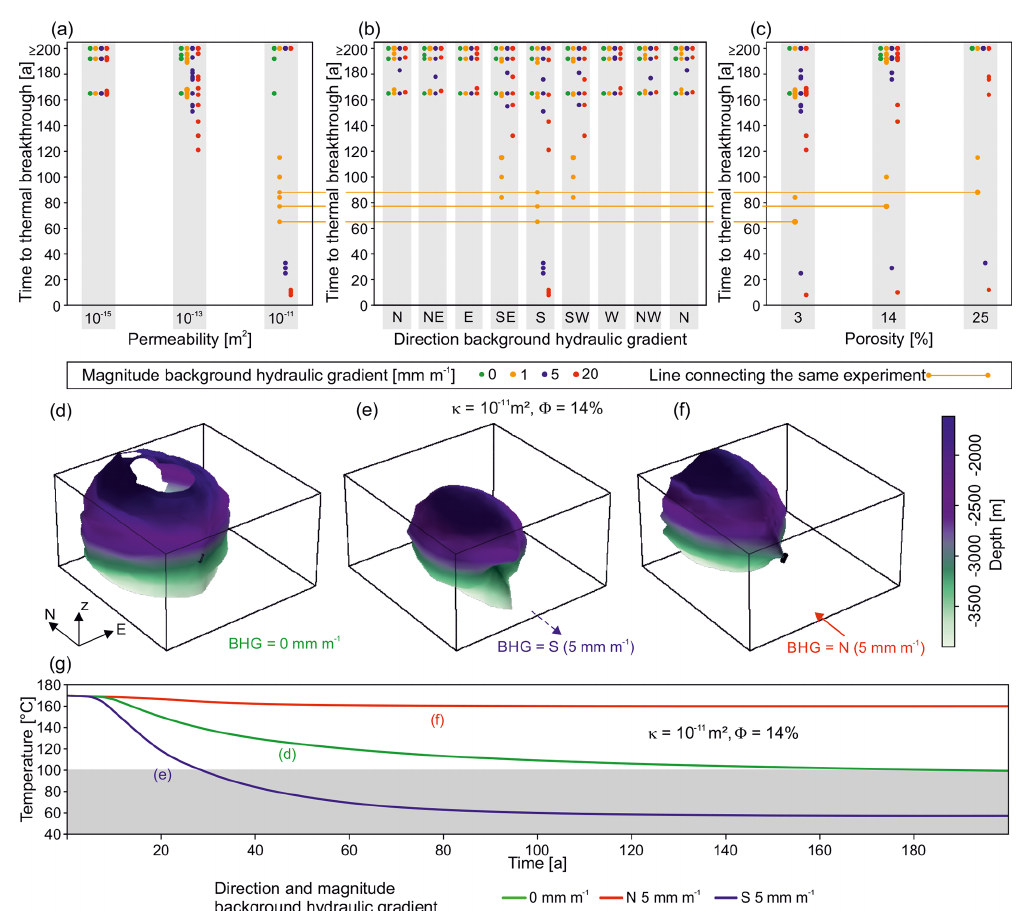
Figure 2. Parameter values against time to thermal breakthrough for model experiments with homogenous and isotropic structure (Scenario 1). Panels (a) , (b) , and (c) each contain the same results of 225 simulations but are arranged according to different x axes. The results show that with increasing permeability, the BHG becomes the prime factor that determines time to thermal breakthrough, while the effect of porosity is minor. Panels (d) , (e) , and (f) show the shape of the HDI after 100 years for a model with a permeability of 10 − 11 m 2 and porosity of 14%, with no BHG (d) , with a BHG of 5mmm − 1 to the S (e) , and with a BHG of 5mmm − 1 to the N (f) . At high permeabilities and magnitudes of the BHG, the shape of the HDI becomes ellipsoidal. Panel (g) shows the development of the production temperature over time for the models presented in (d) – (f)